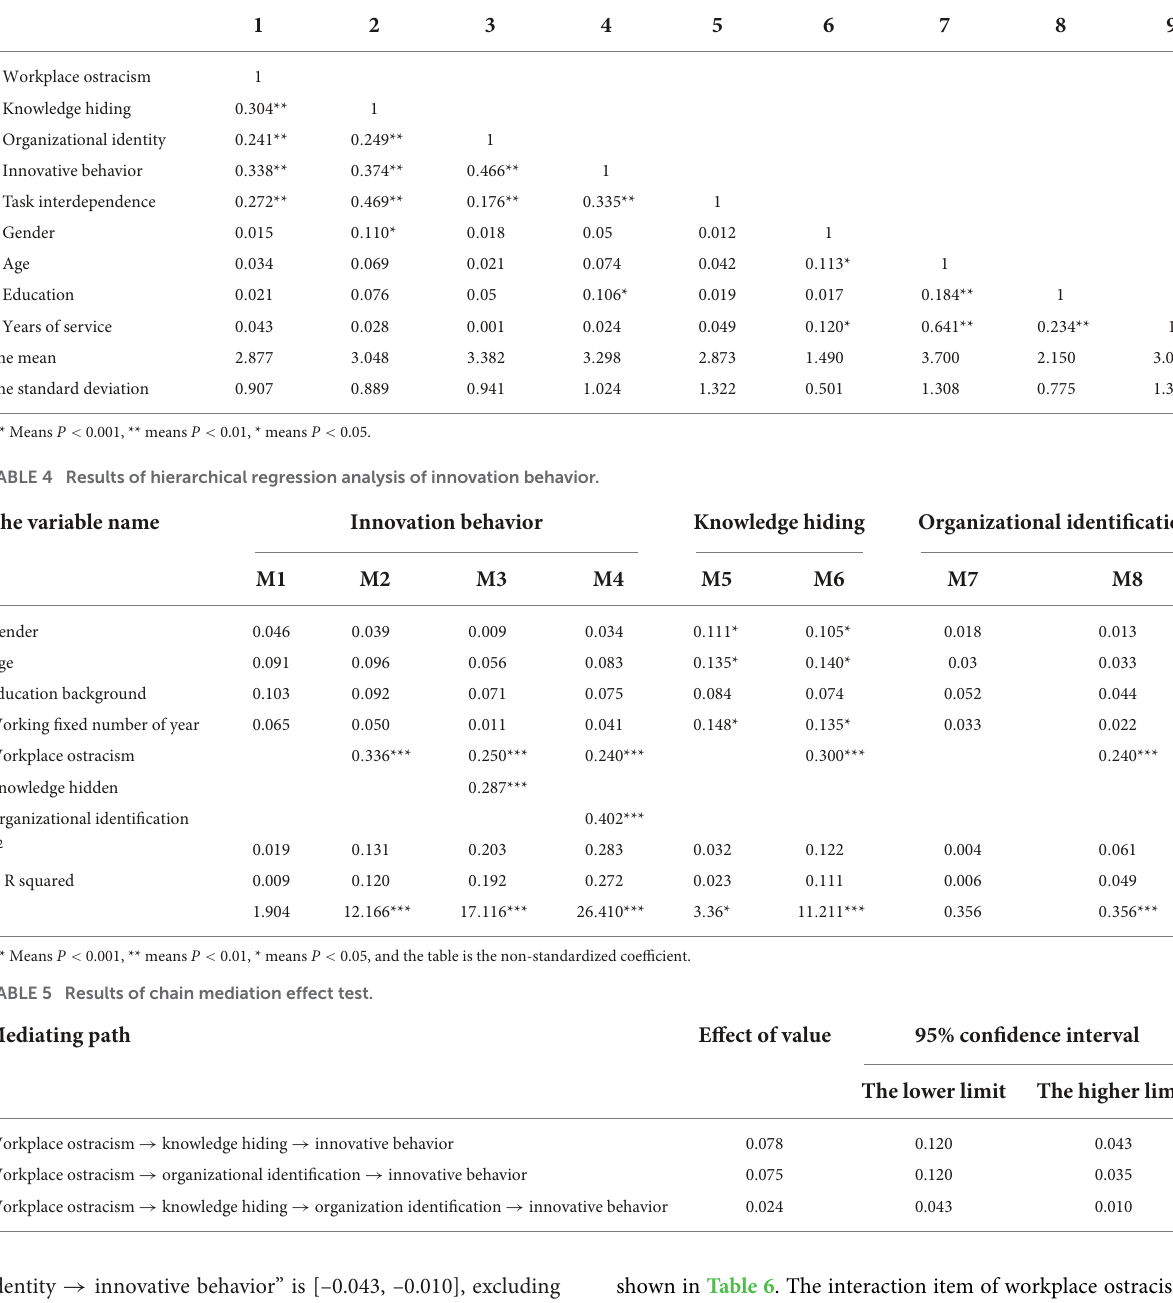
TABLE 3 Descriptive statistical analysis of variables.